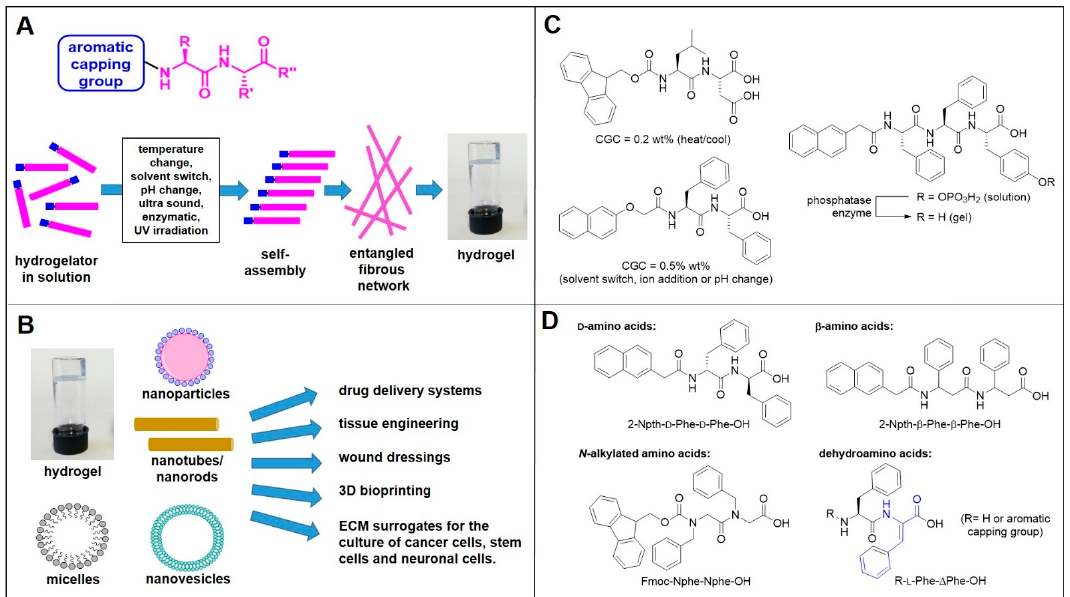
Figure 1. ( A ) Schematic of the formation of peptide hydrogels. ( B ) Biological applications of supramolecular peptide hydrogels and related nanostructures. ( C ) Examples of well-studied supramolecular peptide hydrogelators. ( D ) Some peptidomimetic strategies in the design of supramolecular hydrogels.